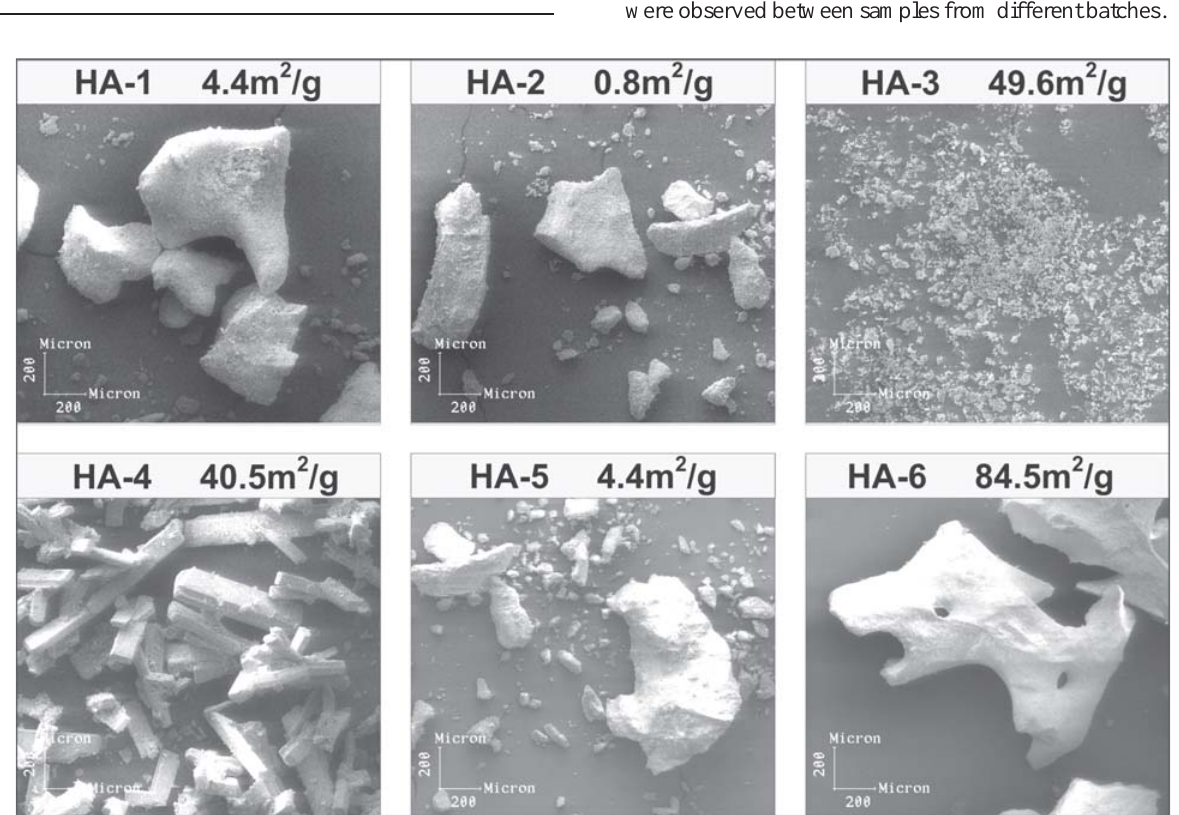
FIGURE 1- Scanning electron micrography (50x magnification) and the BET specific surface area for each